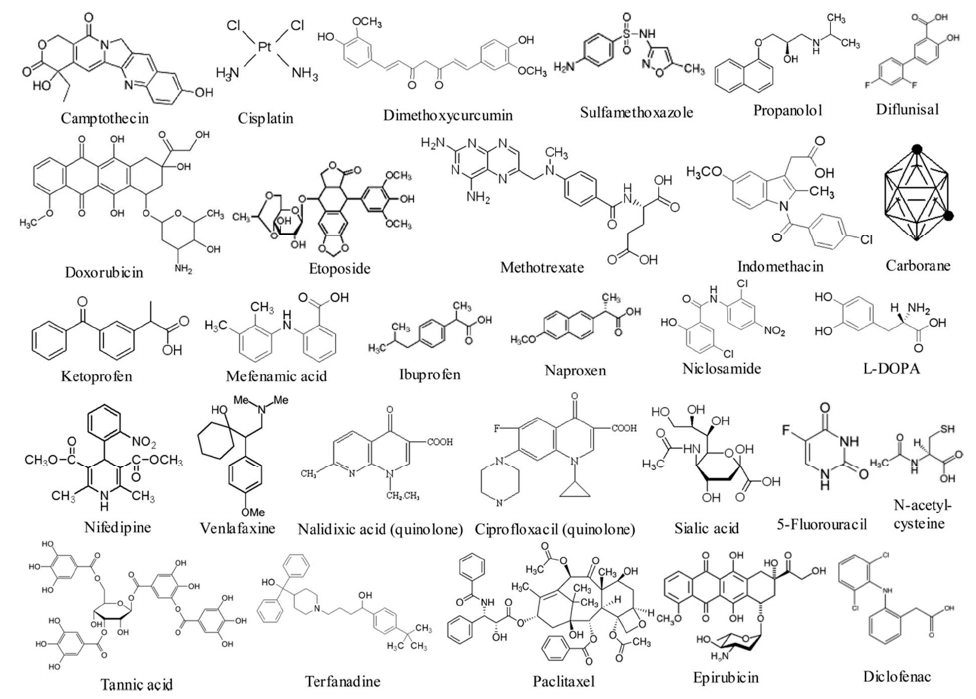
Figure 16. Molecular structures of drugs either encapsulated or stabilized by dendrimers as of 2010. Reprinted with permission from [60]. Copyright 2010 American Chemical Society.